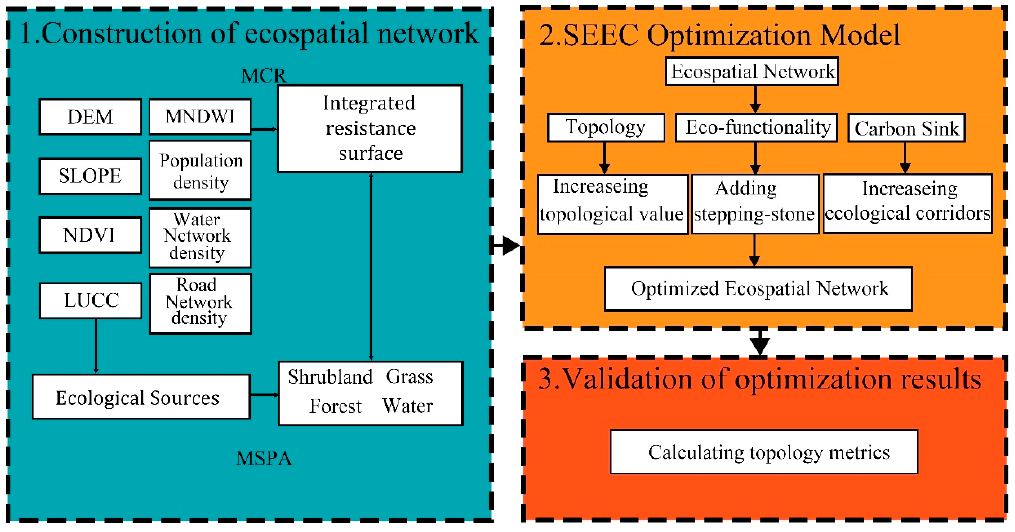
Figure 3. Research